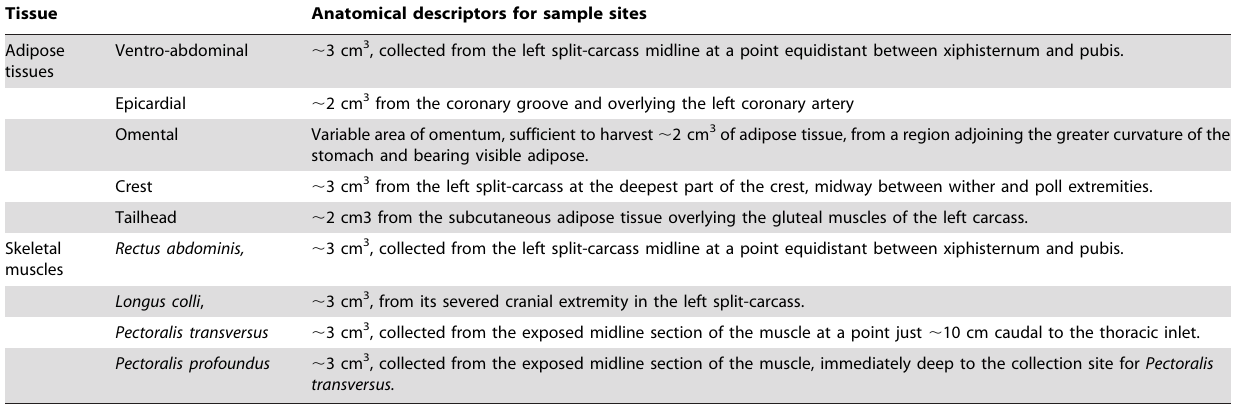
Table 2. Specific anatomical descriptors used to locate the tissue collection points for the 5 regionally discrete adipose tissue depots and 4 skeletal muscles sampled from horses used in the current